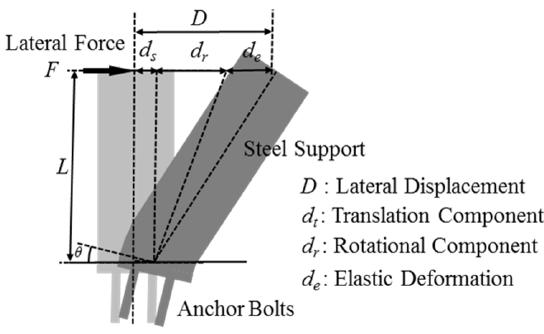
Figure 7. Components in lateral displacement.